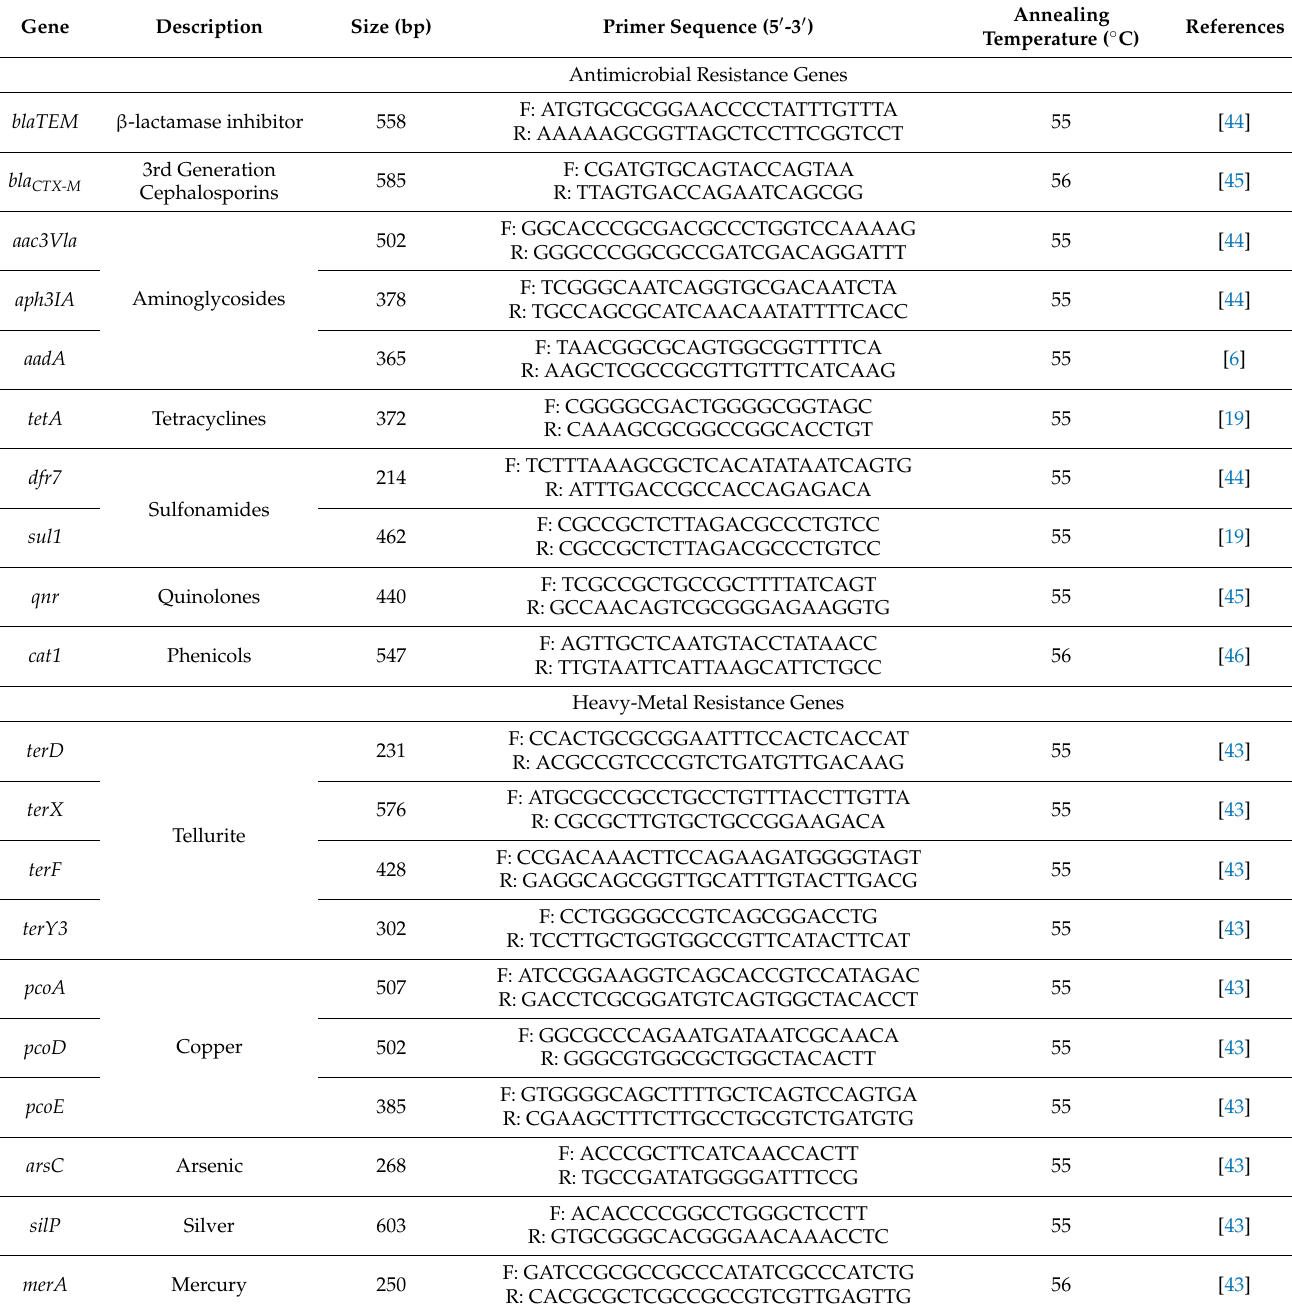
Table 2. Primer sequences and annealing temperatures used for PCR analysis of antimicrobial and heavy-metal resistance